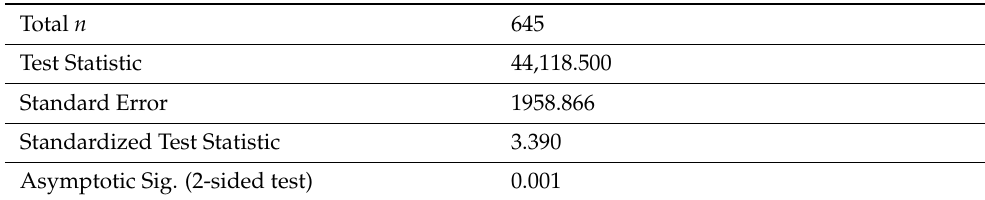
Table 11. Sectoral participation in the economy independent-samples Jonckheere–Terpstra test for ordered alternatives